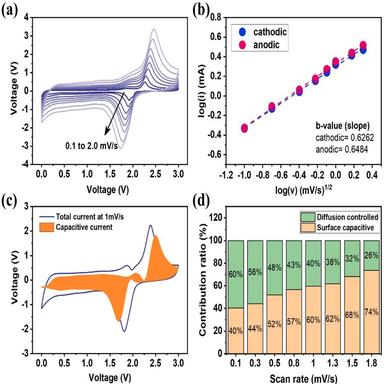
Kinetic analysis of lithium-ion storage behavior in the V2Se9 electrode. (a) CV curves of V2Se9 at various scan rates ranging from 0.1 to 2.0 mV s − 1 . (b) Log (i) vs log (v) plots for each redox peak of the electrode. (c) CV curves showing the contribution of pseudocapacitive currents (orange region) at a scan rate of 0.8 mV s − 1 . (d) Capacity contribution obtained from CV curves at different scan rates.